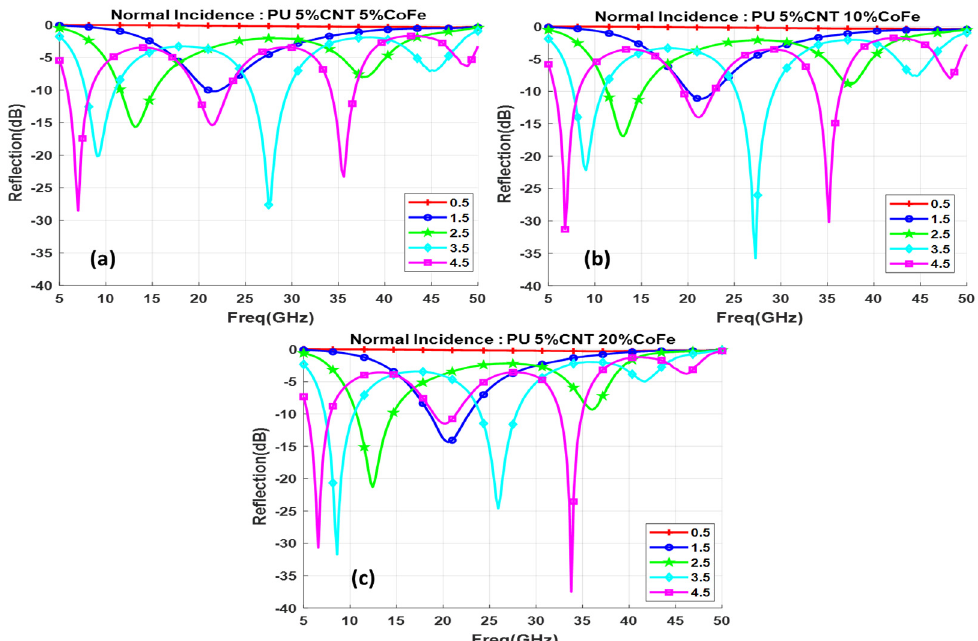
Figure 14. Reflection loss for functionalized composite with different thicknesses (d mm) for ( a ) 5% CoFe, ( b ) 10% CoFe, ( c ) 20% CoFe.